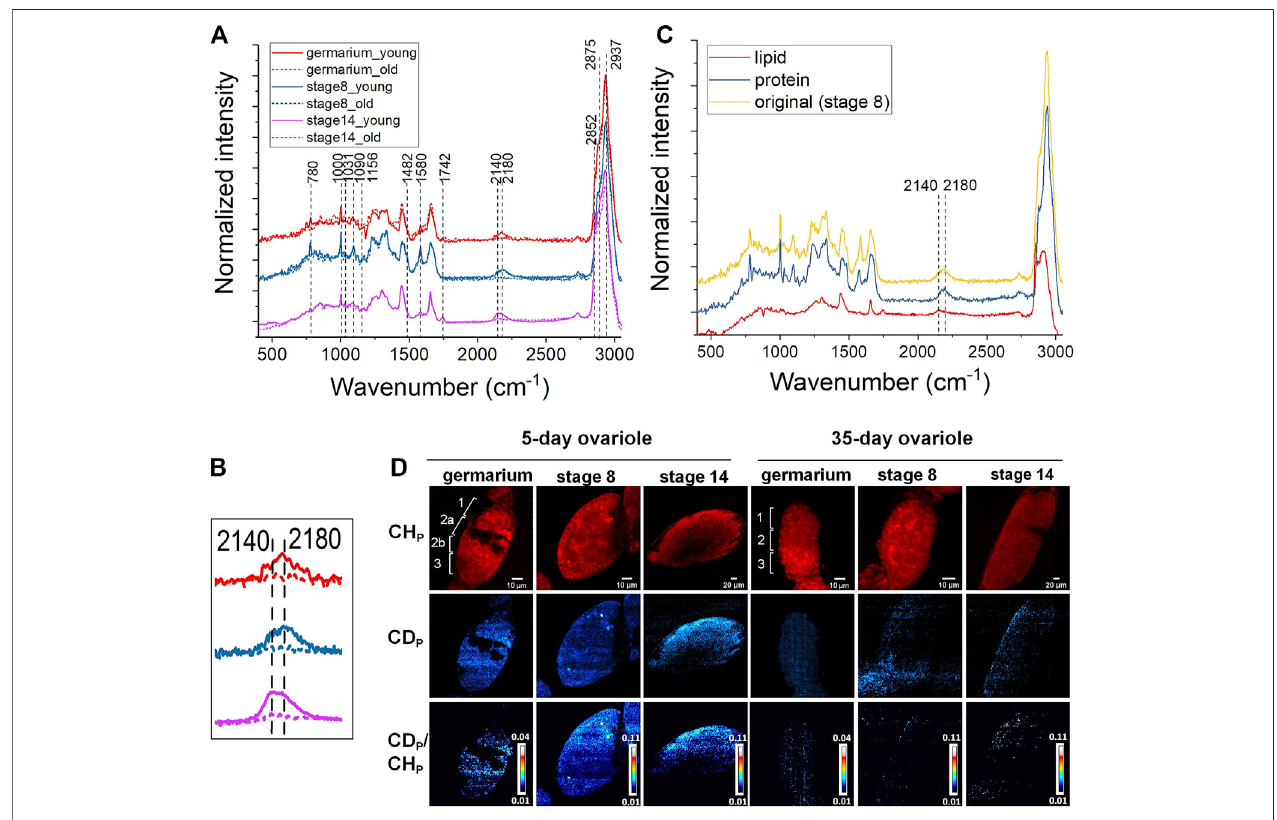
FIGURE2| DO-RamanspectraandDO-SRSimagingofchangesinlipidandproteinmetabolicactivitiesinaging Drosophila ovary. (A) Averagedspectraoffollicles at different developmental stages in 5- (solid line) and 35-day (dashed line) old fl ies ( n (cid:1) 10). The fl ies were treated with 20% D2O for 5 days. A decent CD signal was showninthecellsilentregion.TheCDintensitywasgreatlyreducedin35-day-old fl ies. (B) TheC-Dbondpeakedatlowerwavenumbers( ∼ 2,140 cm − 1 )resemblednewly synthesized lipids at stage 14, while the C-D peak acquired from the early developing follicles toward a higher wavenumber (around 2,180 cm − 1 ) was mainly assigned to the newly synthesized proteins. Both CD proteins and lipids were reduced in the 35-day-old fl ies (dashed lines). (C) Normalized Raman spectra of follicles before(yellow) and after being treated withprotease K (red) or washed with methanol (blue), respectively. Compared withthe CDpeak shown inthe untreated spectrum (yellow), CD protein (blue) and lipid (red) peak positions were con fi rmed by dissolving lipids with methanol that abolished the peak at 2,140 cm − 1 and removing proteins byproteinaseK treatment thateliminatedthepeak at2,180 cm − 1 ,respectively. (D) DO-SRSimagingofprotein metabolicdynamicinyoungandold Drosophila ovariole. DO-SRS images at 2,180 cm − 1 displayed the subcellular localization of CD (newly synthesized) protein. In the same region of interest, SRS images at 2,937 cm − 1 demonstrated the CH (total) proteins. The ratiometric images of CD p /CH p were generated to show the location of newly synthesized proteins. The scale bars in germarium and stage 8 are 10 μ m, and in stage 14 is 20 µm.